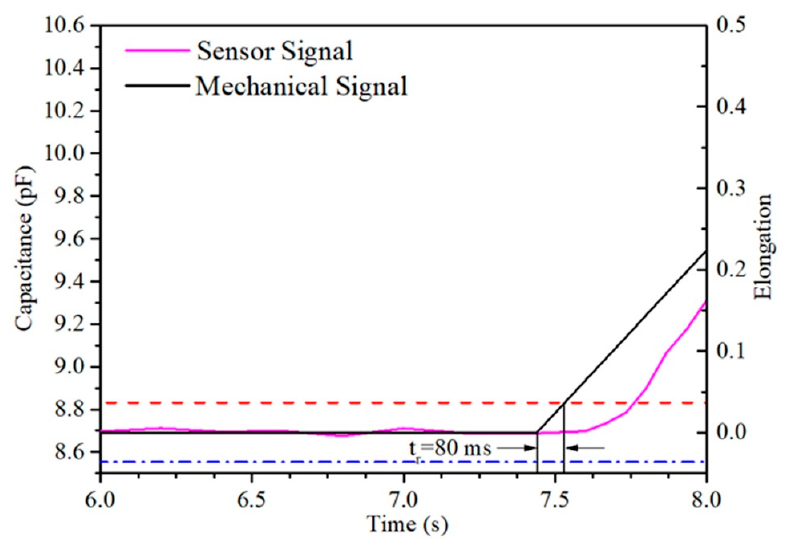
Figure A7. ( a ) Three flexible sensors on the pillow, ( b ) the test circuit diagram of our smart pillow.